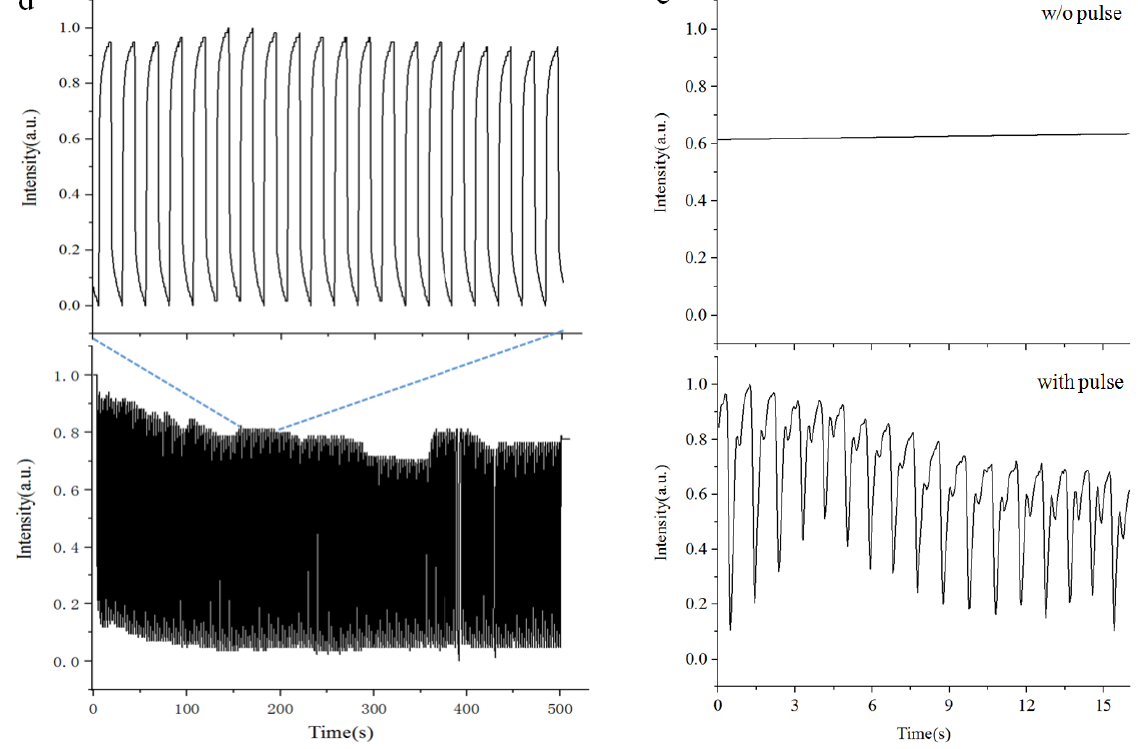
Figure 2. Characterization of the SOFS for strain sensing. Changes in optical intensity output derived from bend and recover tests. Each step corresponds to a displacement of ( a ) 1 µm, ( b ) 2 µm, and ( c ) 5 µm. ( d ) The durability test under a bend of 100 µm at a frequency of ~0.5 Hz. Inset: a magnifying view of the part of the response curve after 75 bend – recover cycles. ( e ) Measurement of the wrist pulse under normal conditions (about 68 beats per minute) and contrast conditions (maintaining the same bending extent without pulse).